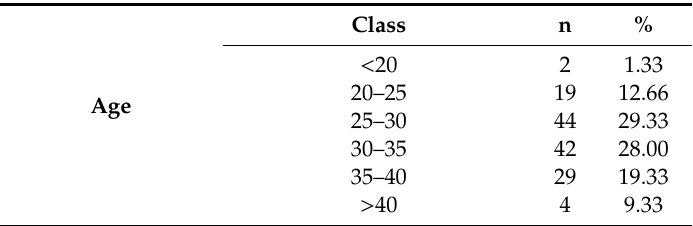
Table 1. Sample characteristics